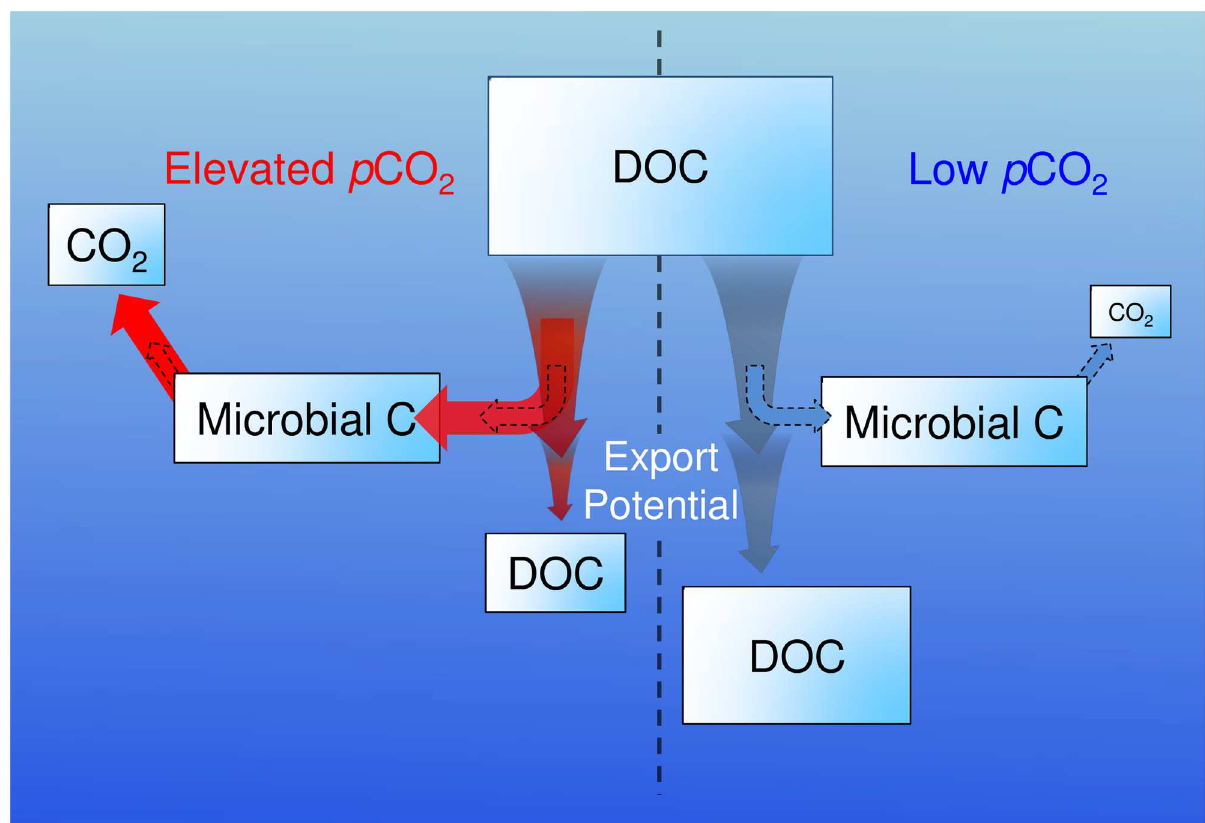
Fig 7. Effects of p CO 2 on bacterioplankton removal of organic carbon. A depictionof the short-term effects of p CO 2 on the use of DOC by bacterioplankton communities in ocean surface waters. Elevated p CO 2 may increasethe use of DOC at loweredbacterioplanktongrowth efficienciesby natural bacterioplankton communities, increasingthe respiration of DOC and decreasingthe magnitudeof accumulatedDOC in these regions, ultimatelydecreasingthe amount of DOC available for vertical export (i.e. export potential). Arrows represent the flux of carbon betweenidentifiedpools. Red represents processesoccurringunder elevated( > ambient) p CO 2 conditions whileblue represents processes occurring under low (ambientor pre-industrial) p CO 2 conditions. Dotted black arrows denotethe flux of carbon betweenidentified pools at low p CO 2 to enablean easy comparisonbetweenelevated and low p CO 2